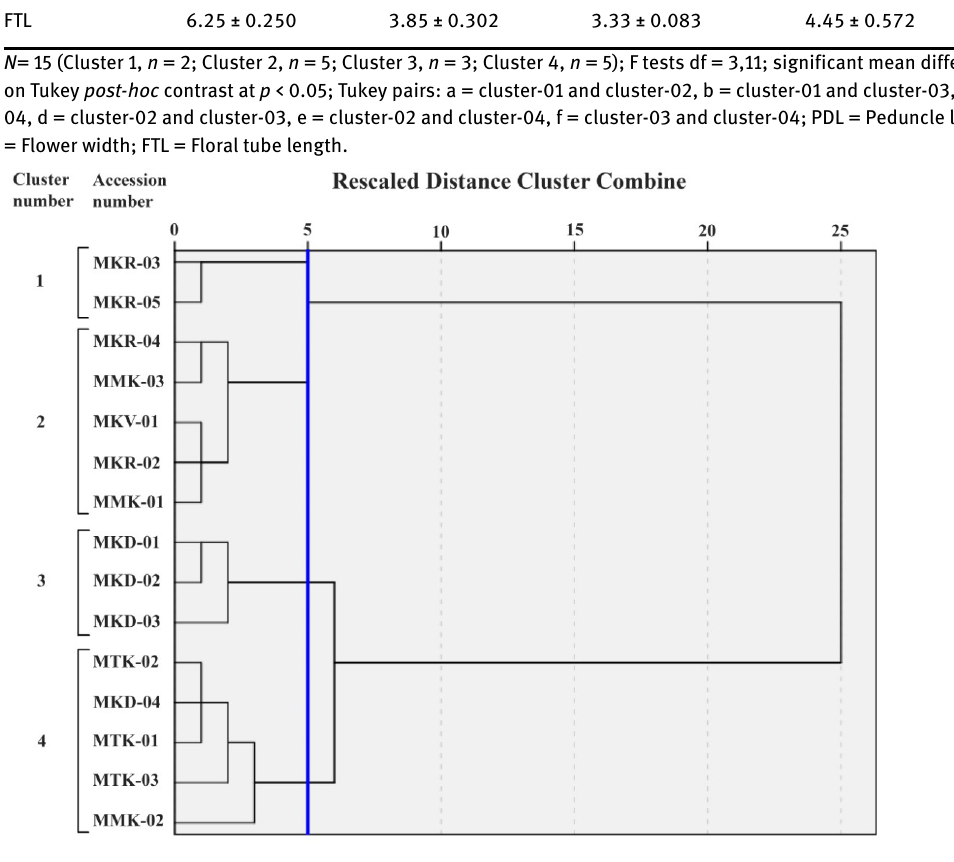
Figure 2: Cluster analysis of fifteen cinnamon accessions based on four morphological